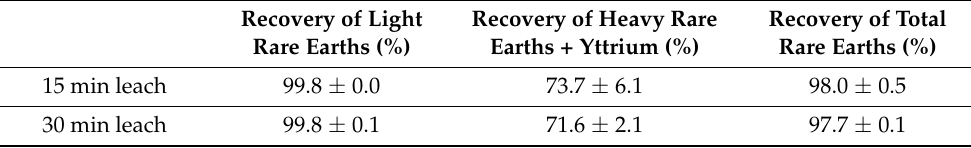
Table 8. Overall light and heavy rare earth dissolution (%): Queensland zircon